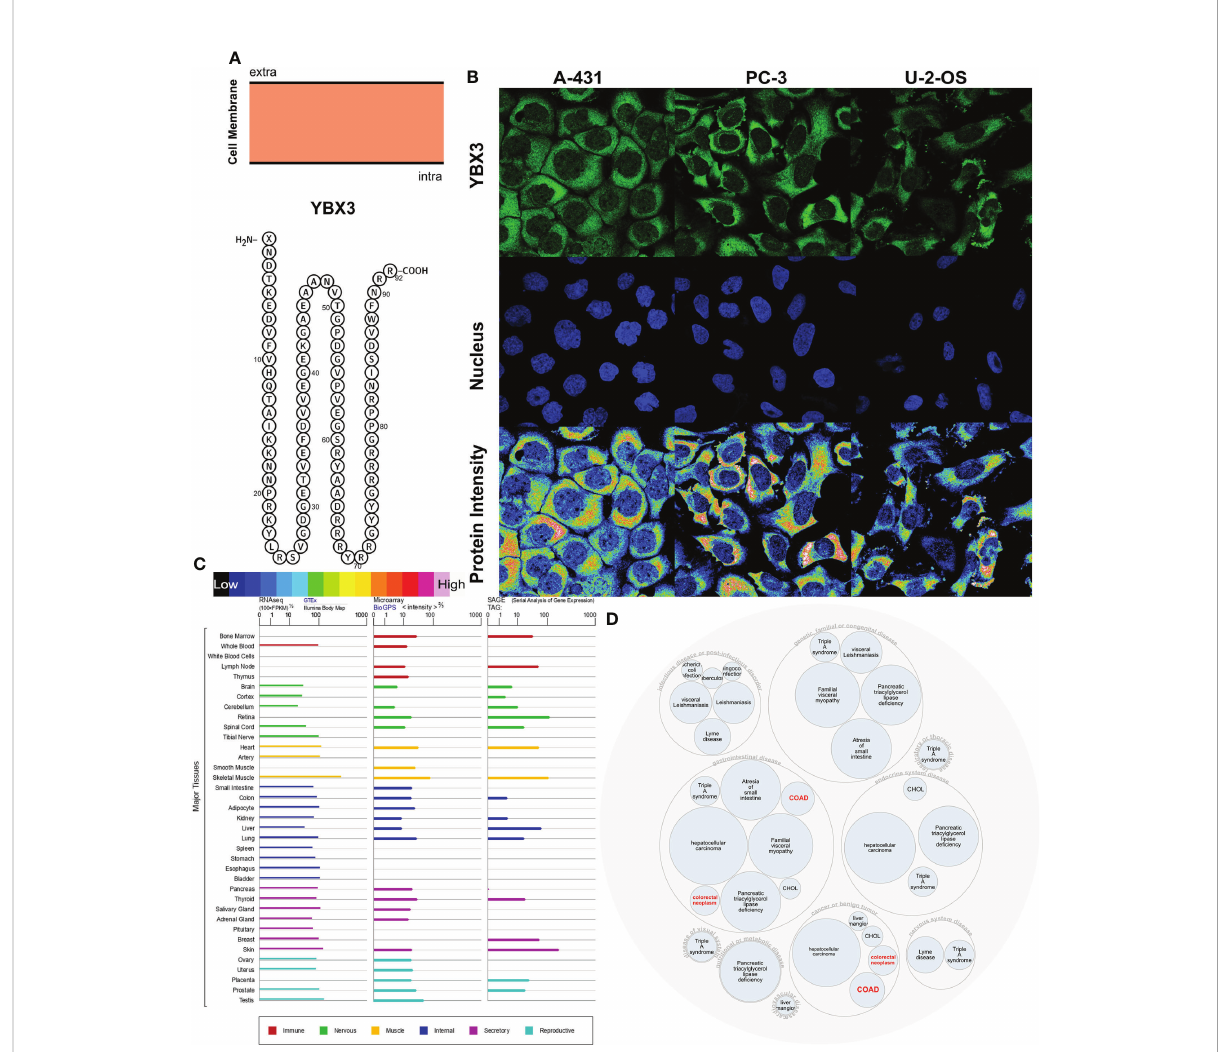
FIGURE 5 Localization, single-cell variation, and expression pro fi le patterns of YBX3. (A) YBX3 protein topology. (B) Immuno fl uorescence staining of the subcellular distribution of YBX3 within the cytoplasm and nucleus of A-431, PC-3, and U-2 cell lines as adopted from the HPA database. (C) Bar plot of YBX3 mRNA expressions in diverse normal human tissues from the GTEx database. (D) Construction of YBX3-associated disease